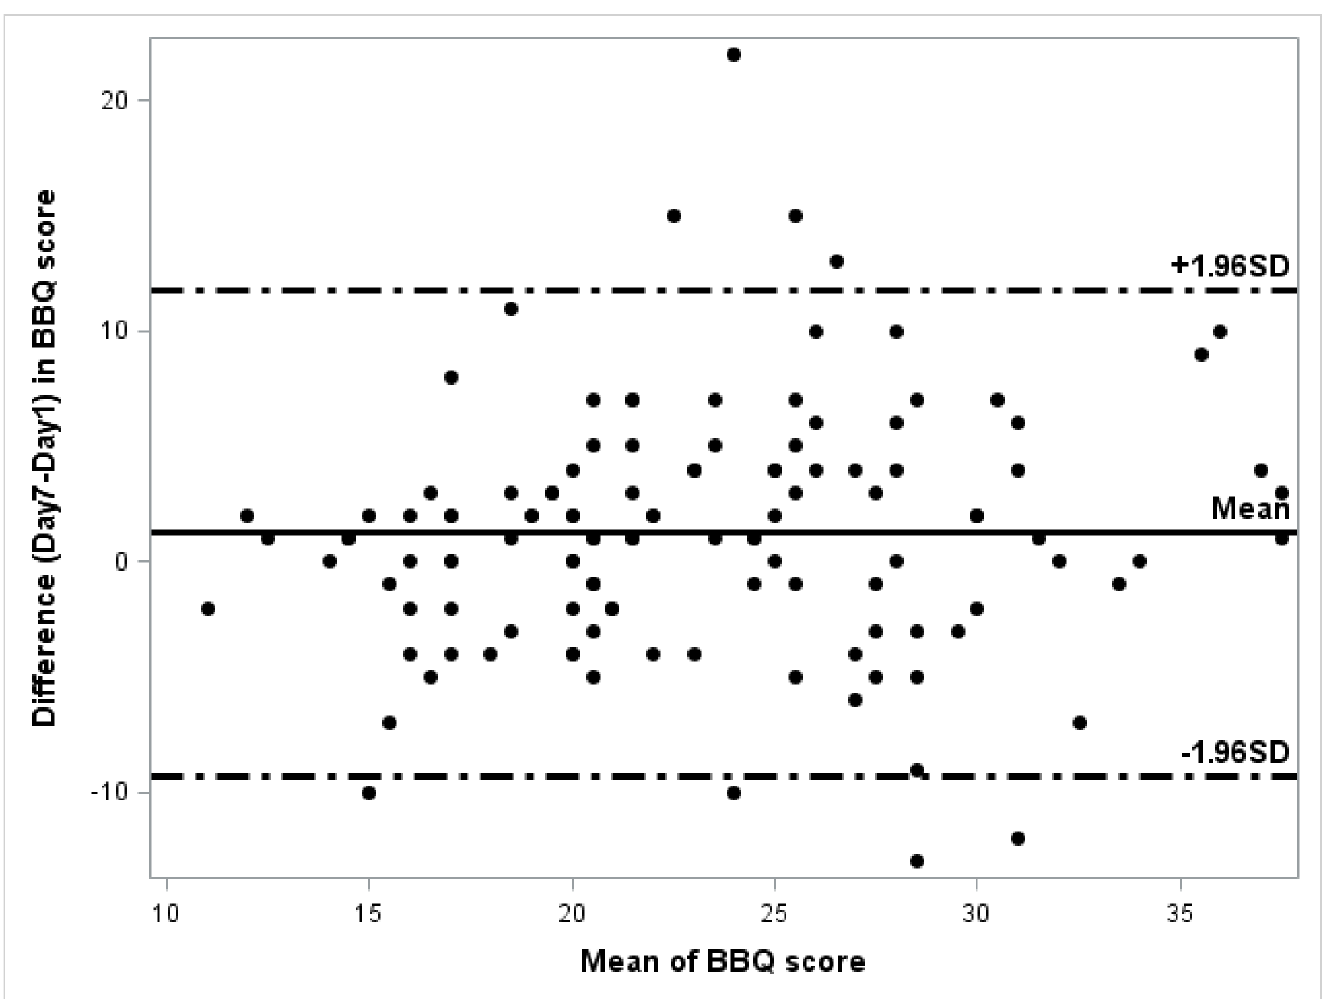
Fig 3. Bland & Altman method representation of a bias in the test-retest reliability method to assesstemporal stability between D1 and D7. A bias betweenthe mean differencescan be detected. Here the score calculatedat the second visit is +1.24 higher.